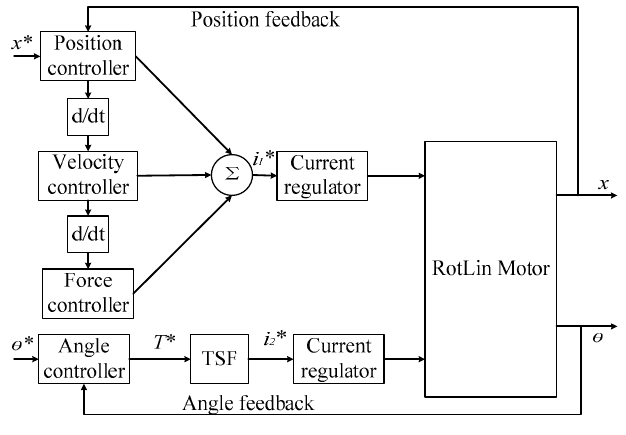
Figure 10. Control scheme of the RotLin motor.